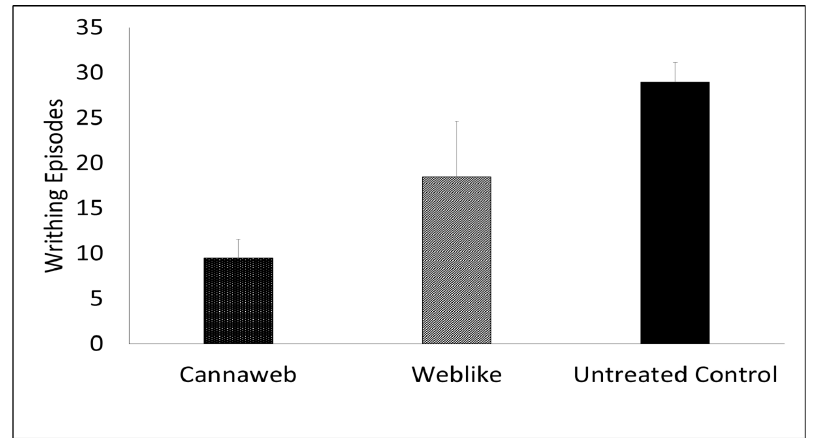
Figure 7. Mean writing counts in mice treated with 100 mg/kg CBD topically from F16 (Cannaweb containing 3% HSO), ( n = 5) and F17 (Weblike not containing HSO), ( n = 4), each containing 5% w / w CBD. The treatment was carried out 1 h prior to IP injection of acetic acid and, compared to un- treated control mice, received an IP injection of acetic acid ( n = 4) (Mean ±SD). p < 0.01 (considered very significant) for Cannaweb containing HSO vs. Untreated control group, p < 0.05 (considered significant) for Cannaweb containing 3% HSO vs. Weblike not containing HSO, by One-Way ANOVA.